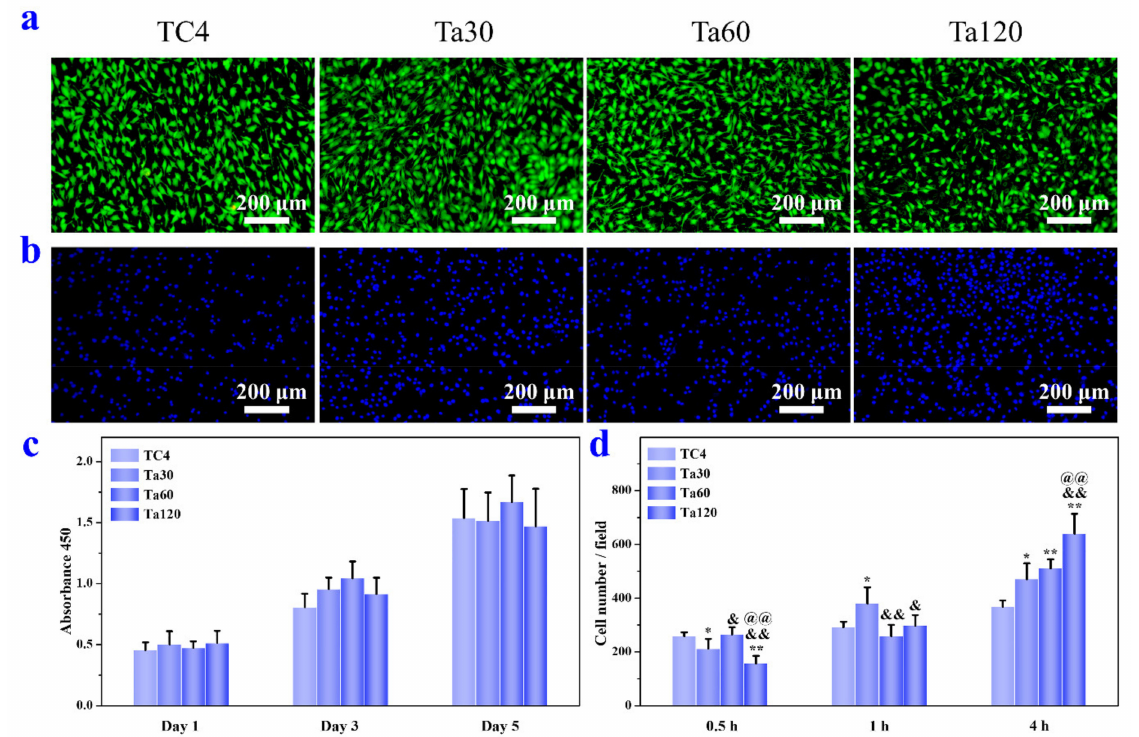
Figure 7. ( a ) Fluorescence images of LIVE/DEAD staining of osteoblasts cultured on Ta coatings for 3 days. ( b ) Fluorescence images of cells adhered on Ta coatings for 4 h. ( c ) Viability of osteoblasts after culturing for 1, 3, and 5 days. ( d ) Quantitative results of osteoblasts adhesion after culturing for 0.5, 1 and 4 h. Mirror polished TC4 was used as control. * p < 0.05 and ** p < 0.01 compared to TC4, & p < 0.05 and && p < 0.01 compared to Ta30, @@ p < 0.01 compared to